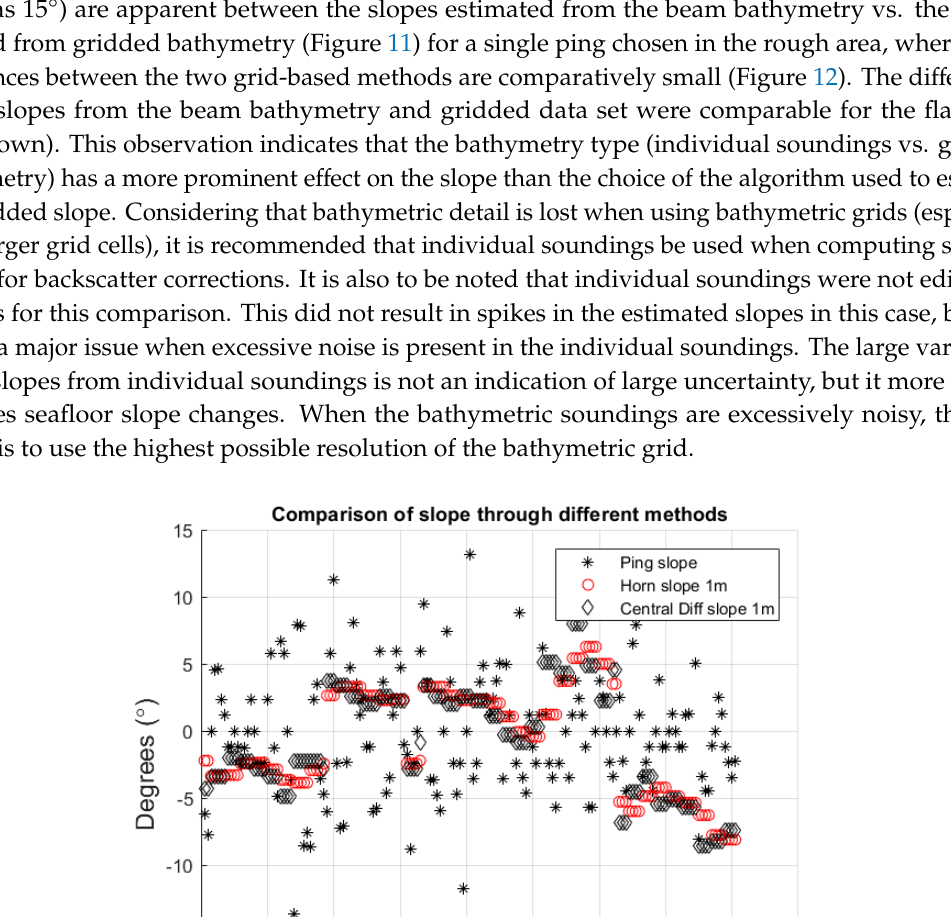
Figure 12. Comparison of the estimated magnitude of slopes from the entire survey area using the ( a ) central difference and ( b ) Horn methods applied to data gridded to 1 m cell sizes. ( c ) Difference in slope computed using the two methods shows that it is <0.3° in flat areas and <1° in rough areas.